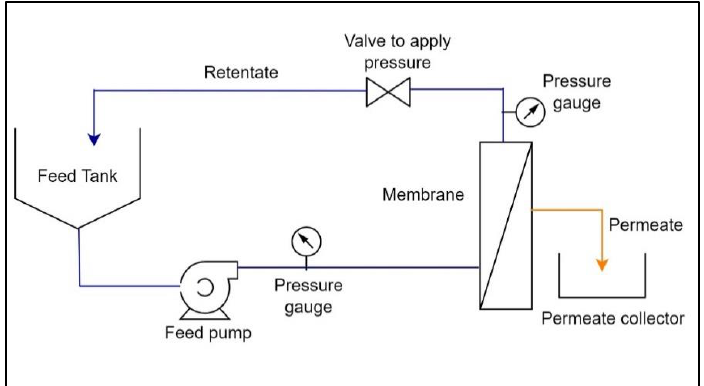
Figure 3. Flow diagram of the crossflow filtration.